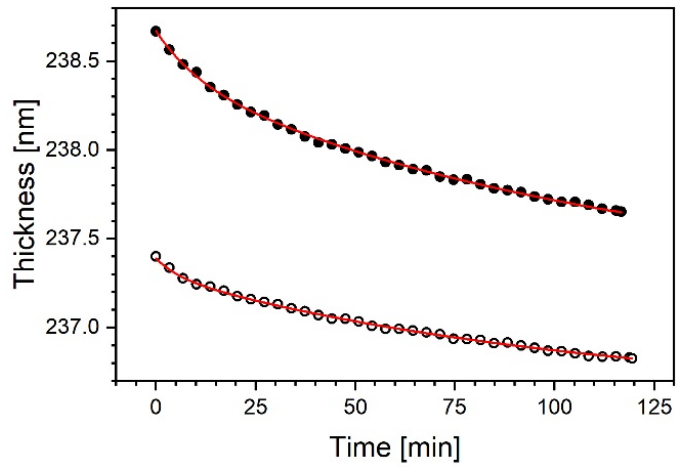
Figure 6. The 20% Sample. Thickness variation as function time at 290 °C, calculated for first (full circles) and second annealing (open circles) using Sellmeier model for data (b) in Figure 4. Continuous lines are fits of a double exponential decay.